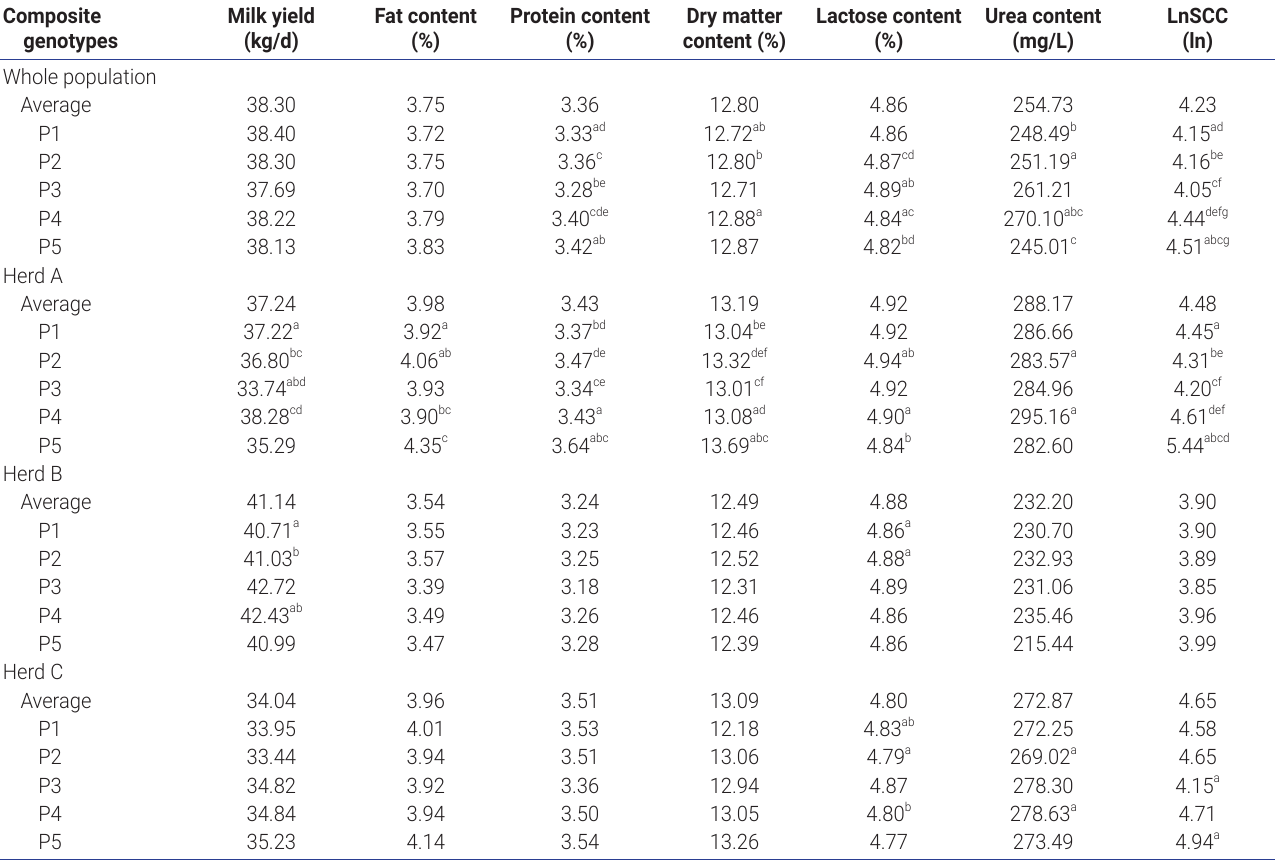
Table 5. Impact of progestogen-associated endometrial protein composite genotypes on milk parameters (p<0.05) Composite